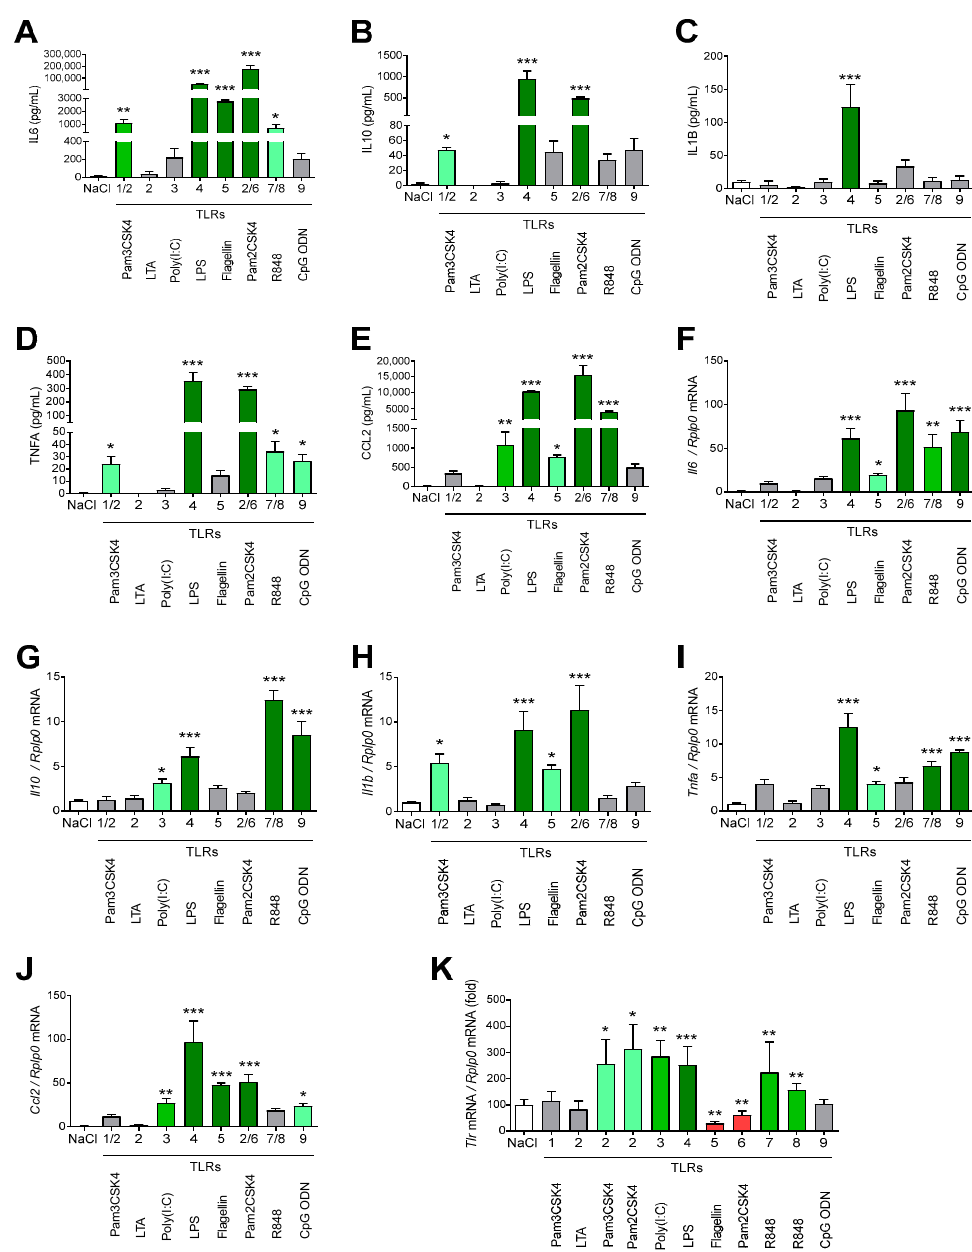
Figure 2. Toll-like receptor (TLR) agonists increase cytokines and Tlr expressions. Evaluation of the inflammatory status in mice 3 h after intraperitoneal injection of sodium chloride (NaCl) (control group; n = 9) or TLR agonists: Pam3CysSerLys4 (Pam3CSK4; TLR1/2 agonist; 1 mg/kg; n = 5), lipo- teichoic acid (LTA; TLR2 agonist; 1 mg/kg; n = 5), Pam2CysSerLys4 (Pam2CSK4; TLR2/6 agonist; 1 mg/kg; n = 5), polyinosinic–polycytidylic acid (Poly(I:C); TLR3 agonist; 1 mg/kg; n = 5), lipopolysac- charides (LPS; TLR4 agonist; 1 mg/kg; n = 9), fl agellin (TLR5 agonist, 1 mg/kg; n = 5), resiquimod (R848; TLR7/8 agonist; 1 mg/kg; n = 5) and CpG oligodeoxynucleotides (CpG ODN; TLR9 agonist; 0.6 mg/kg; n = 5). ( A – E ) Levels of plasma cytokines (pg/mL): interleukin-6 (IL6), interleukin-10 (IL10), interleukin-1 beta (IL1B), tumor necrosis factor alpha (TNFA) and C-C motif chemokine lig- and 2 (CCL2). ( F – J ) Quanti fi cation of cytokines mRNA levels in the ileum (compared to ribosomal protein lateral stalk subunit P0 ( Rplp0 ) mRNA): Il6, Il10, Il1b, Tnfa and Ccl2 . ( K ) Quanti fi cation of Tlr mRNA levels in the ileum (compared to Rplp0 mRNA); results are expressed as fold induction of the NaCl group. Statistical analyses were performed using the Kruskal–Wallis test; * p < 0.05, ** p < 0.01 and *** p < 0.001. All results are expressed as mean ± SEM.